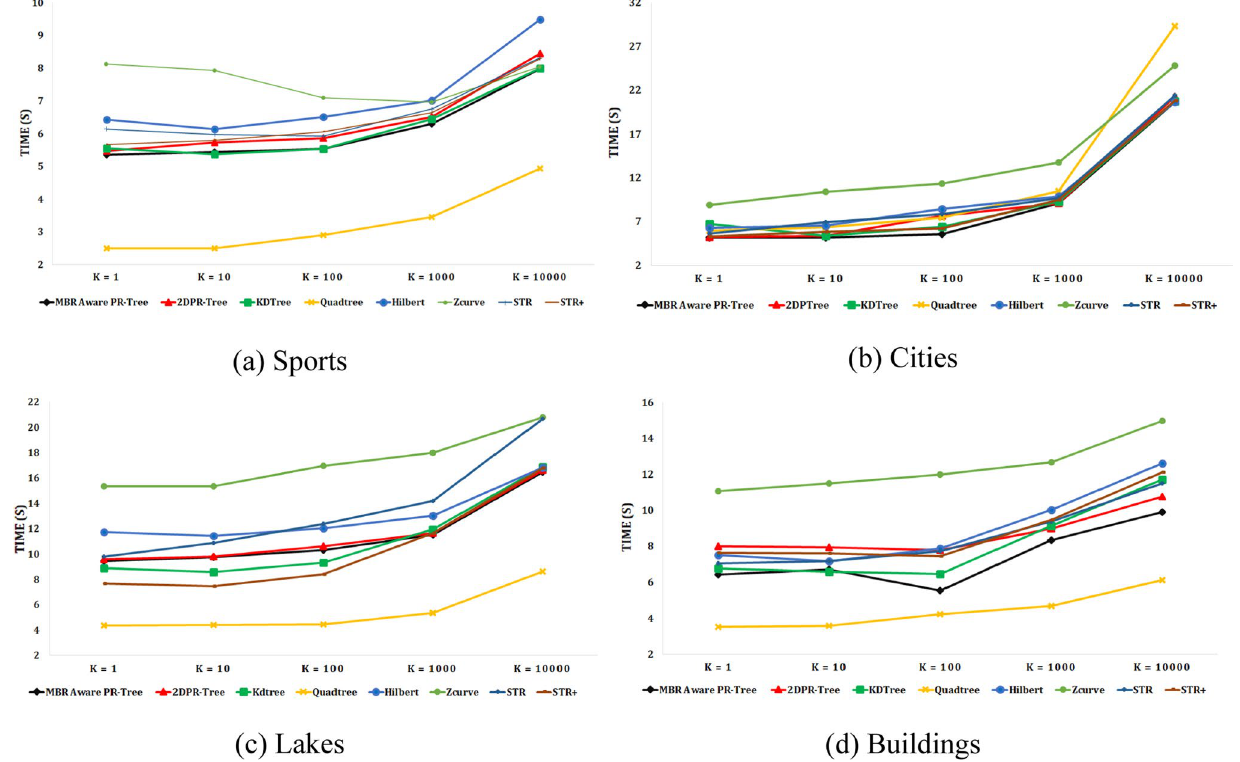
Fig. 14 kNN query execution time for Sports, Cities, Lakes and